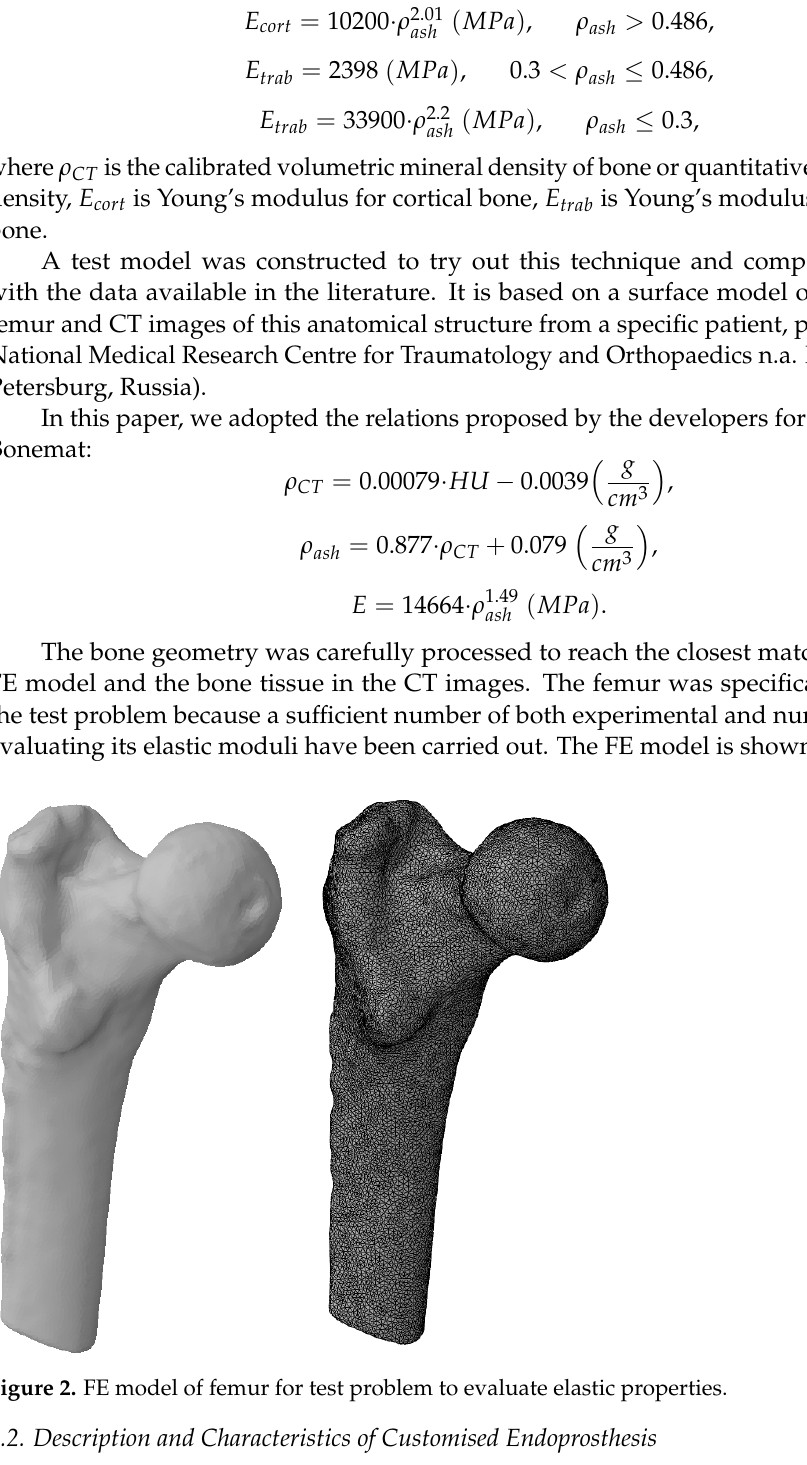
( b ) Figure 3. CT images: ( a ) before surgery; ( b ) after surgery. The acetabular component in THR is cementless and consists of a cup and a trabecu- lar rod that is inserted into the ilium through a hole in the cup and then sealed with a plug (Figure 4). The endoprosthesis is equipped with an L-shaped flange with holes for tita- nium screws used to initially fasten the implant to the pelvic bone. The device includes three Ø6.5 mm cancellous screws and three Ø4.5 mm cortical screws. The inner surfaces of the flange directly contacting the bone are covered with a po- rous structure to ensure the ingrowth of bone tissue into the endoprosthesis and proper osseointegration. The outer layer of the rod is also made as a porous trabecular-type struc- ture. Since we did not simulate the liner, head, and plugs in this study, these components are not illustrated in the paper.